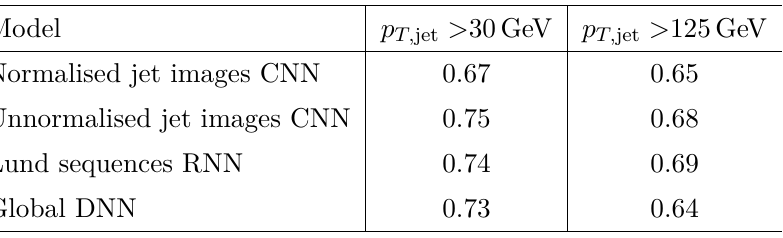
Table 3 . Area under the ROC curve of the different Deep Learning architectures for the separation of the Vacuum and Medium samples in the pre-defined case ( p 30 GeV) and in the large jet T, jet > transverse momentum regime ( p 125 T, jet >